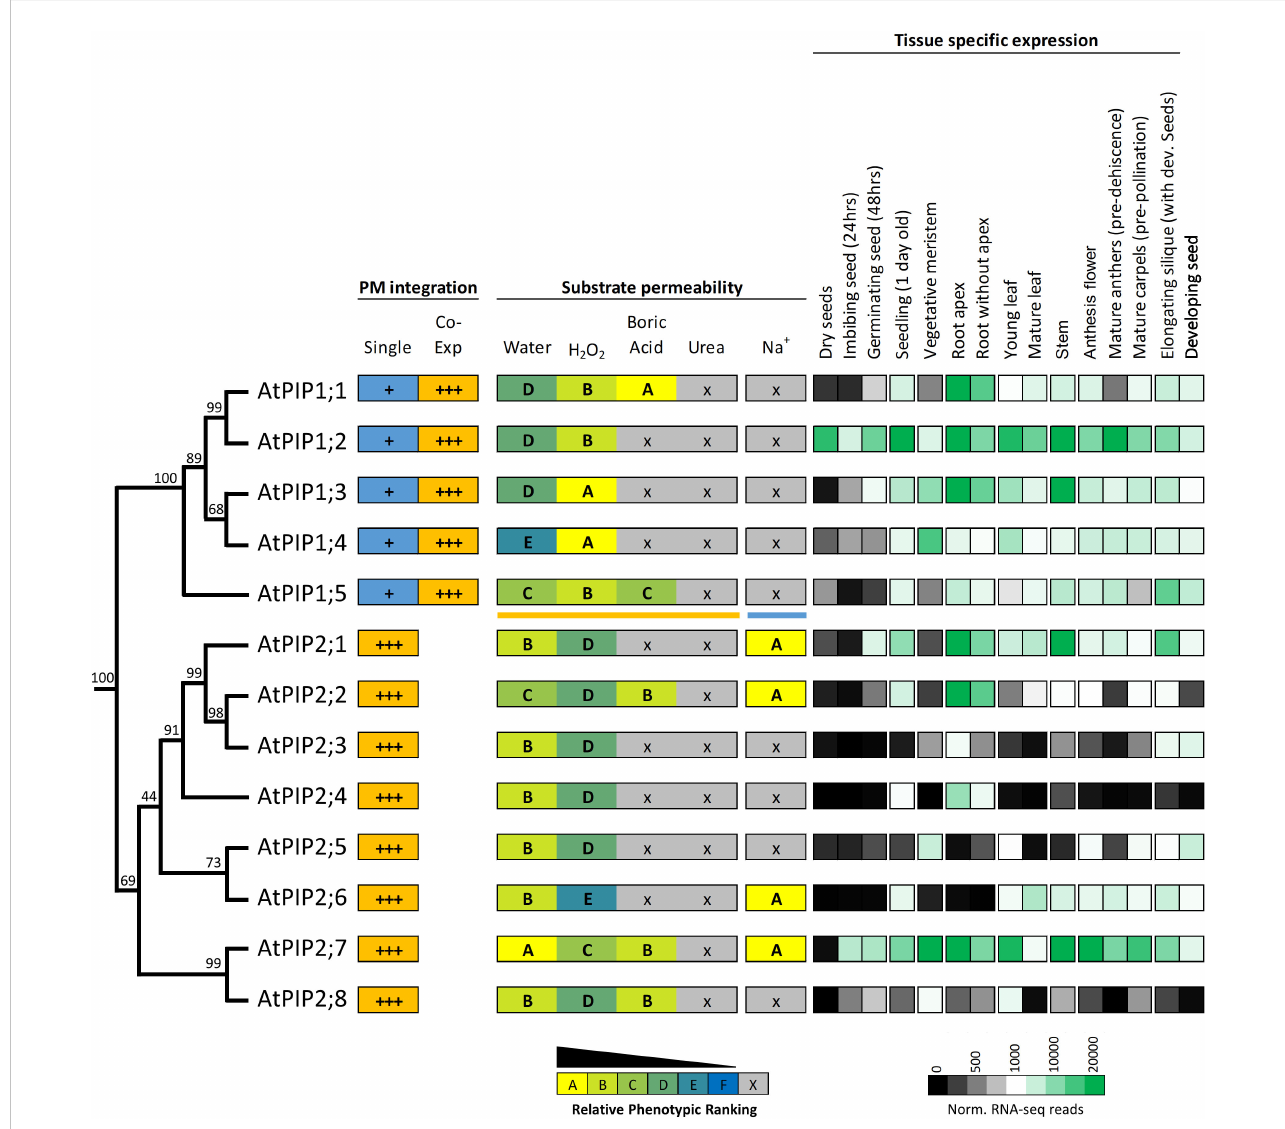
FIGURE 9 Summary of permeability and expression data for the AtPIP isoforms. The phylogenetic relationship is shown on the left, followed by strength of integration into the plasma membrane (PM) when expressed singly or co-expressed with a PIP2 (PIP1s only). Substrate permeabilities are shown in the center, and relative gene expression across different tissues during development, are shown on the right. The phylogeny is full protein sequence, using neighbor-joining method from MUSCLE alignments of protein sequences, with con fi dence levels (%) of branch points generated through bootstrapping analysis (n = 1000). Relative phenotype ranking for AtPIP1s are based on co-expression with AtPIP2;5 for water, H 2 O 2 , boric acid and urea (orange underline below AtPIP1;5) and singly expressed AtPIP1s for Na + permeability (blue line under AtPIP1;5). Normalized tissue-speci fi c RNA-seq data was obtained through TRAVA (http://travadb.org/) (Klepikova et al.,